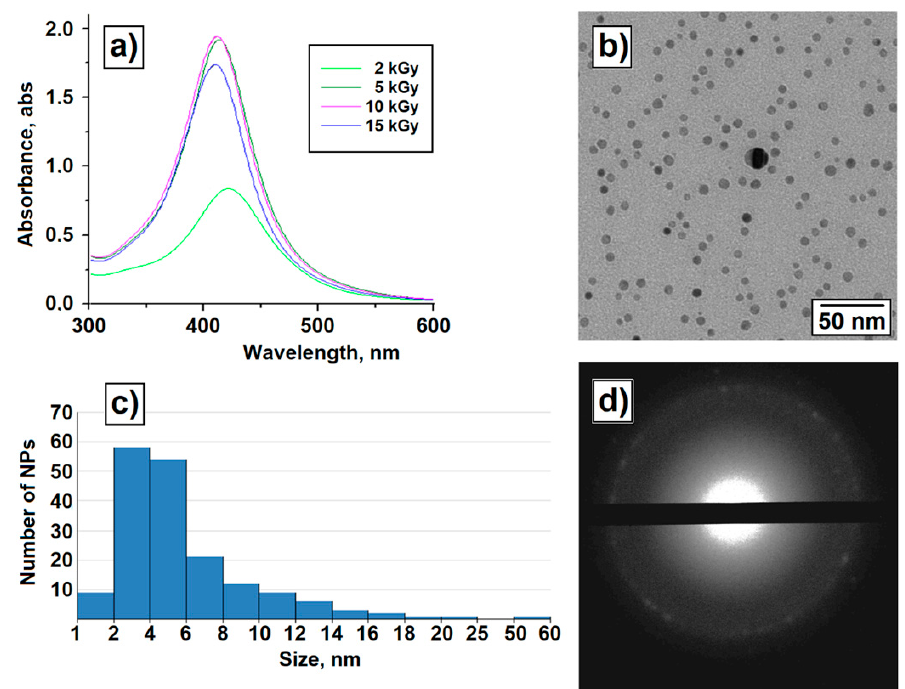
Figure 2. UV–visible spectra ( a ), micrography ( b ), histogram of the size distribution of nanoparticles ( c ), microdiffraction image ( d ) of irradiated PEI-Ag + complexes.